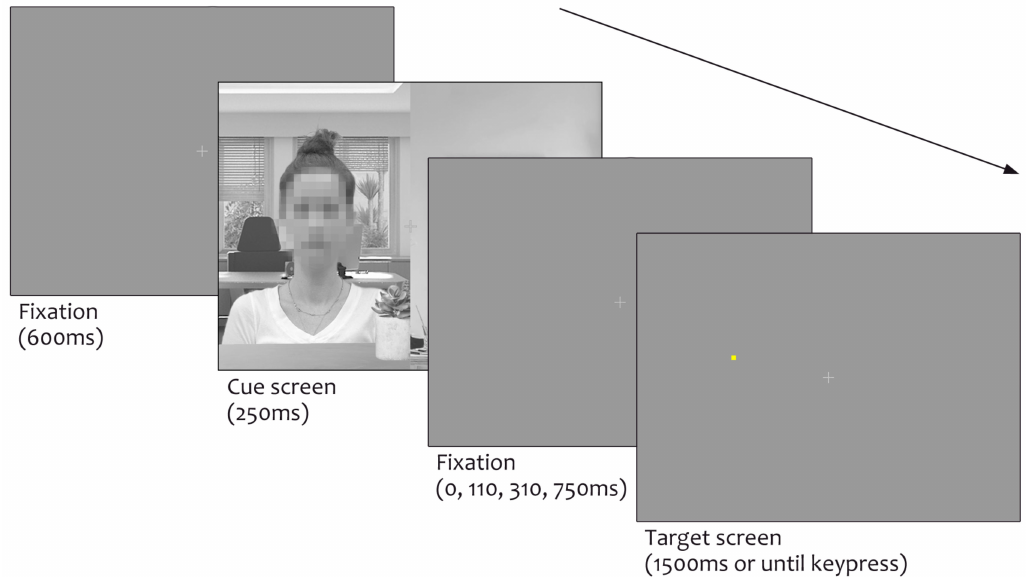
Figure 2. Example trial sequence. Trials began with the presentation of the fixation screen for 600 ms. The cue screen was then presented for 250 ms. After 0, 110, 310, or 750 ms, a target (circle or square) demanding a discrimination response appeared in one of four possible locations. The target remained on screen for 1500 ms or until a key press was